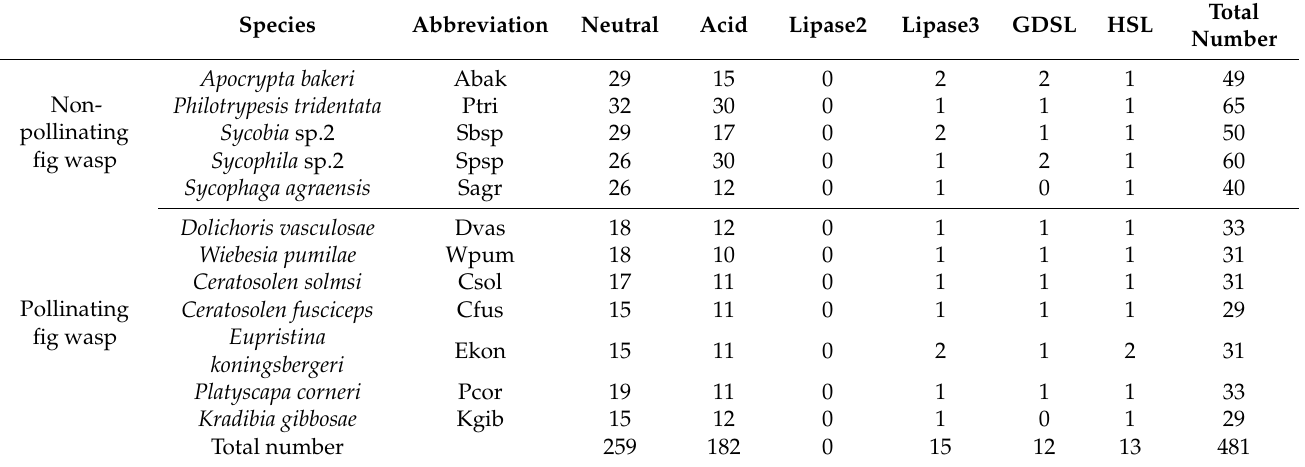
Table 1. Summary of the lipase genes in 12 fig